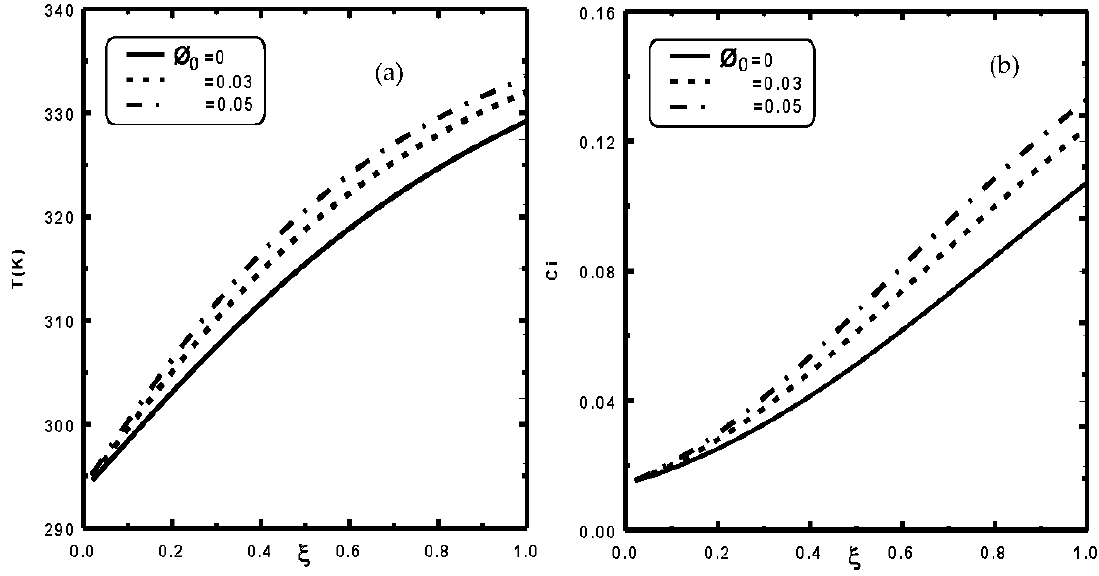
Figure 8. Variation of the temperature ( a ) and vapour concentration ( b ) at the interface liquid-gas for different nanoparticle volume fraction: T 0L = 293.15 K, T 0 = 293.15 K, q 1 = 3000 W/m 2 , c 0 = 0, T w =